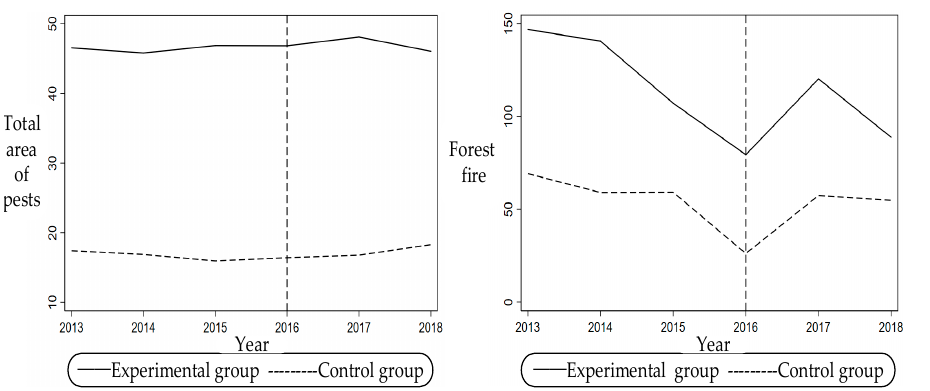
Figure 5. Trends of pest damage and forest fires in policy implementation provinces and non-policy implementation provinces.